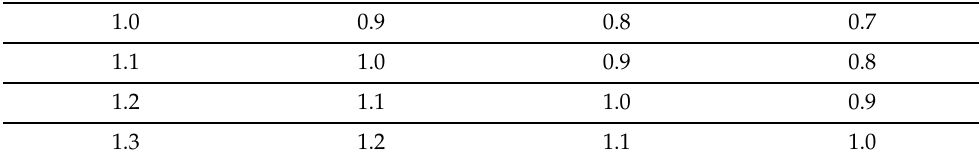
Figure 13. 4 × 4 PWR sub-assembly layout. Table 4. Lateral power profile for the 4 × 4 PWR